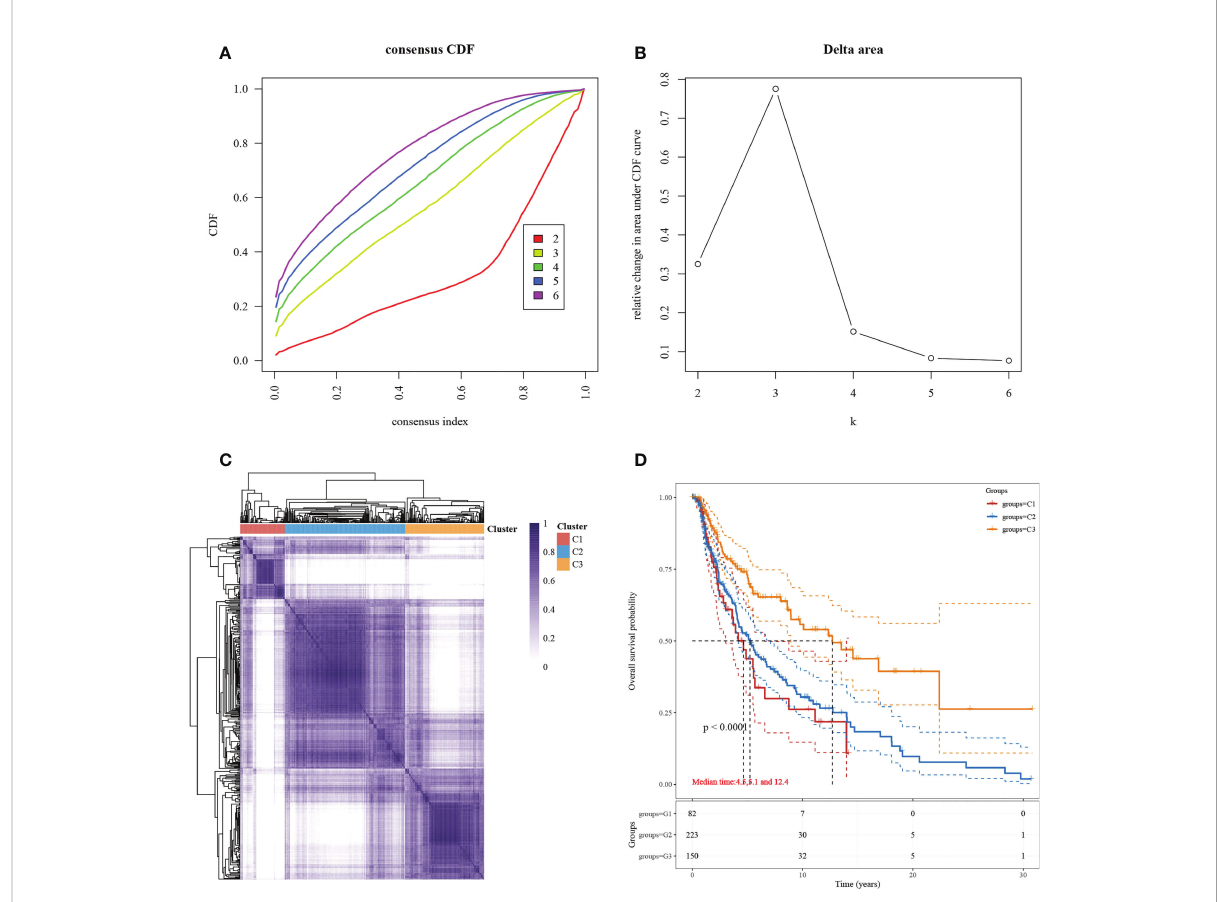
FIGURE 1 Subgroup typing based on necroptosis-associated gene sets. (A) CDF curve. Delta area curve for the consistent clustering and the area under the curve when samples were classi fi ed into different subtypes. (B) CDF delta area curve. The horizontal axis indicates a category number k , and the vertical axis indicates the relative change in area under the CDF curve. (C) A heat map showing consistent clustering results. Different colors indicate different subgroups. (D) KM survival curve distribution, indicating the different subgroups between prognosis comparisons between different